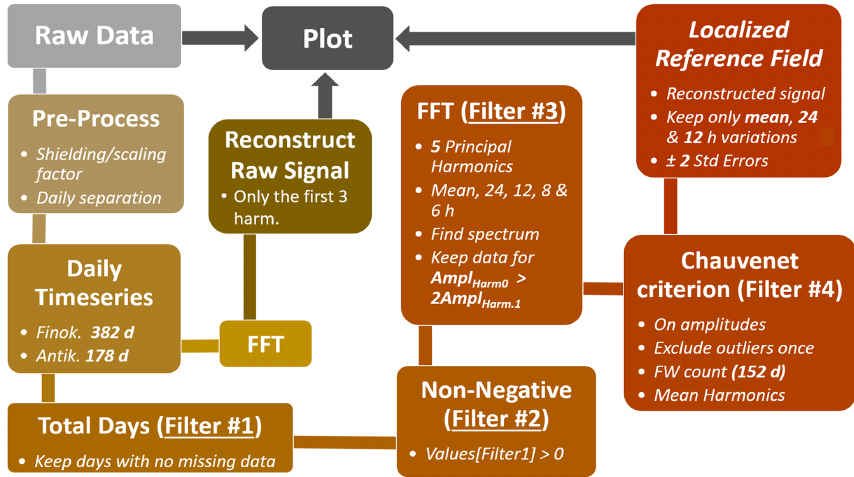
Figure 2. Signal-processing chain for (i) the derivation of the localized reference electric field (LREF) that represents local fair-weather (FW) conditions, following the proposed filtering process (filters no. 1 to no. 4, yellow to orange) of the field mill electric field data as retrieved at both Finokalia (Finok.) and Antikythera (Antik.) atmospheric stations and (ii) the derivation of the daily mean electric field under dust-driven days from the same datasets (yellow to olive green). The LREF is compared to the mean electric field values in order to assess the electric field behaviour. Ampl: amplitude; harm.: